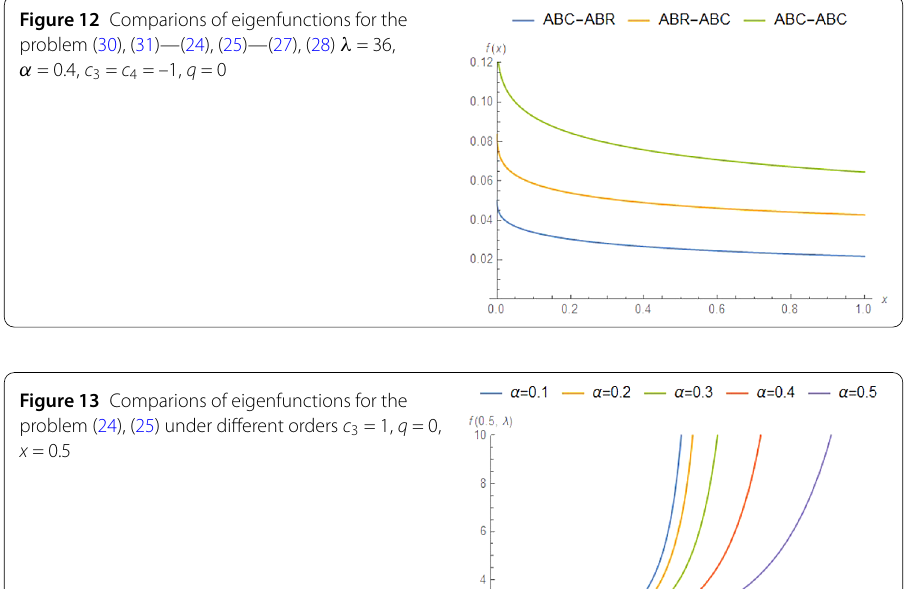
Figure 14 Comparions of eigenfunctions for the problem (24), (25) under different eigenvalues α = 0.4, c 3 = –1, q = 0